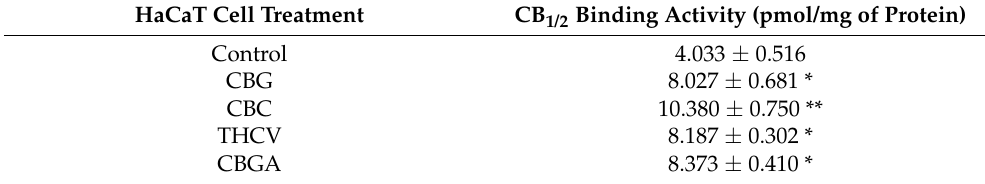
Table 3. CB 1/2 binding activity of HaCaT cells following 24 h of treatment with half-IC 50 amounts of the different pCBs. Data are the means ± SEM of three independent experiments ( n = 3). Statistical analysis was performed using a one-way ANOVA test, followed by the Bonferroni post hoc test (* p < 0.05 and ** p < 0.01 vs.